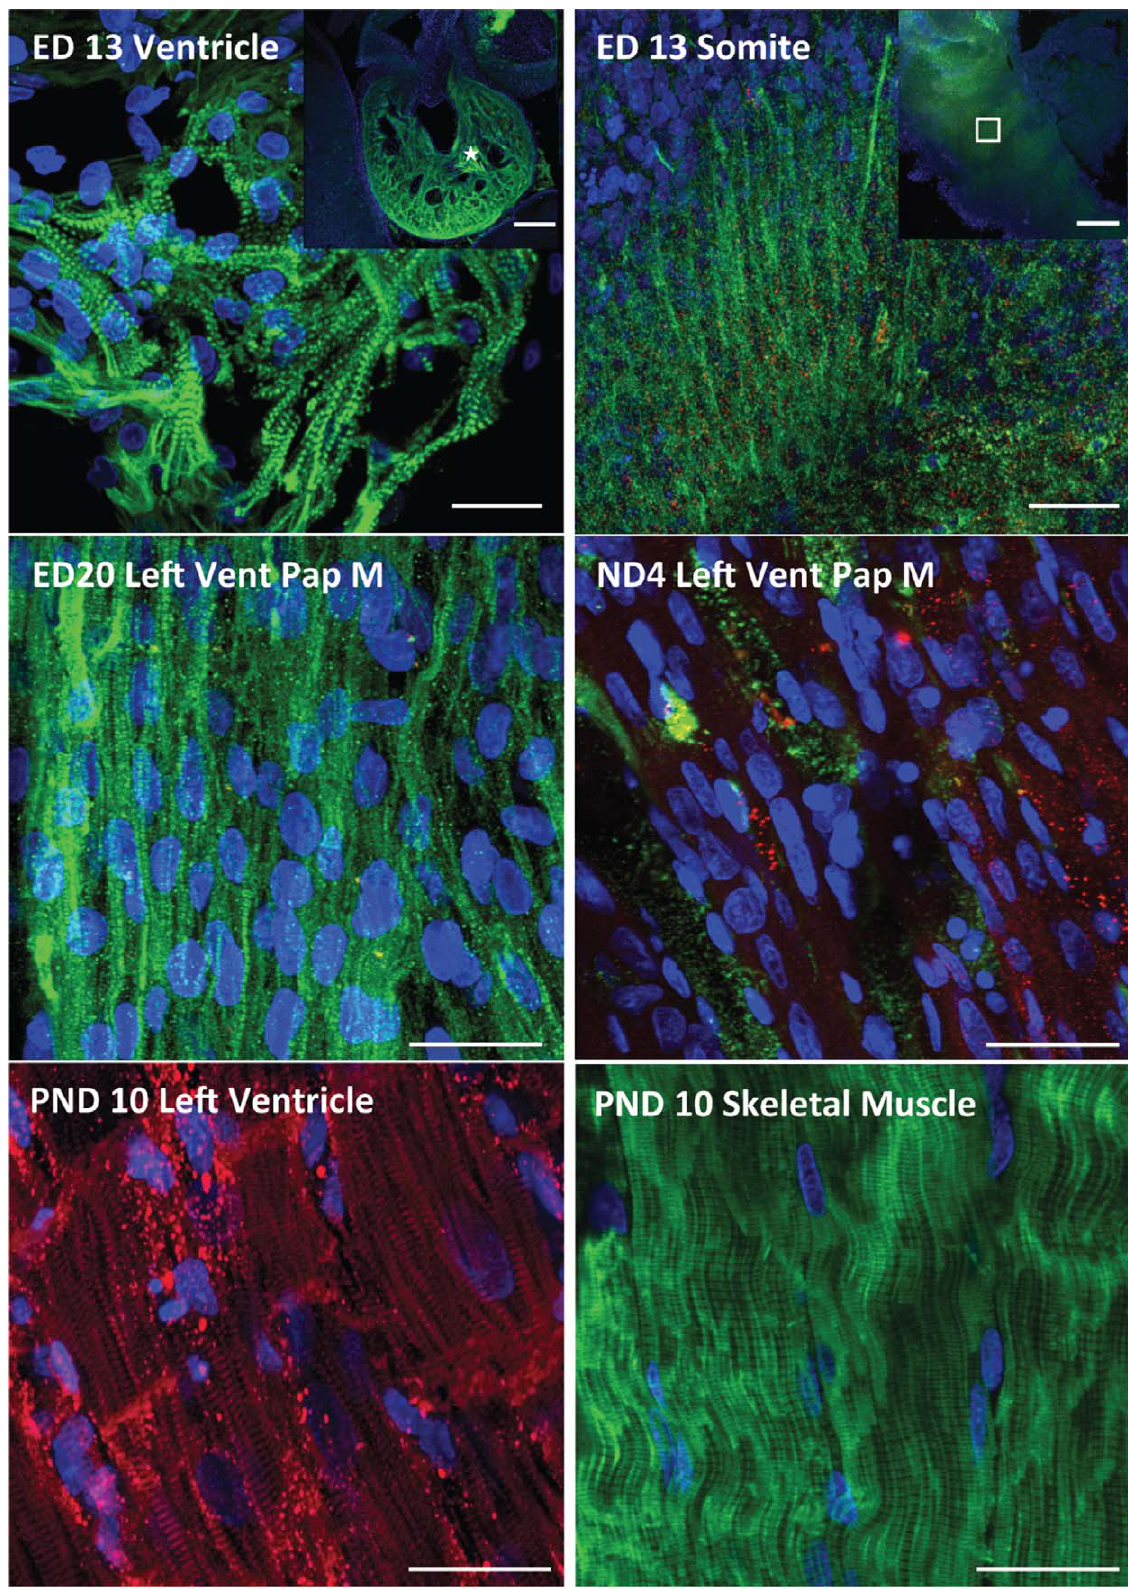
Figure 2. sk-fMHC (green color) and cardiac troponin-I (red color) expression within developing ventricular myocardium and skeletal muscle. The skeletal muscle fast myosin heavy chain (sk-fMHC) and cardiac troponin-I (cTn-I) expression within the embryonic day (ED13) heart (ED13 Ventricle insert, scale indicates 500 m m). The sk-fMHC was expressed as a typical striated muscle pattern in the developing ventricle and